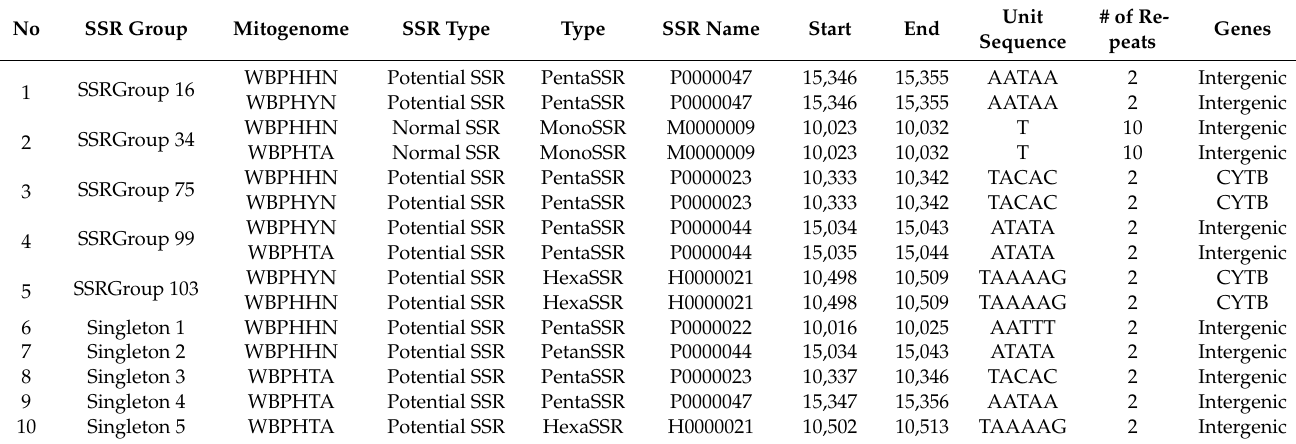
Table 3. List of simple sequence repeats (SSRs) from SSR groups containing one or two